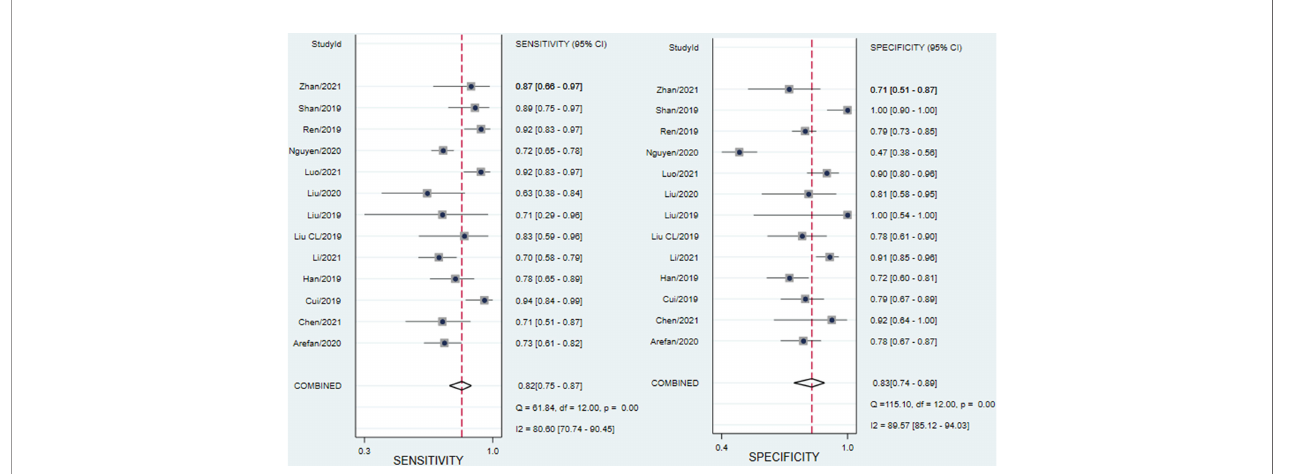
FIGURE 4 | Forest plots of the sensitivity and speci fi city of ML-based radiomics of DCE-MRI in predicting ALNM in breast cancer. I 2 >50% indicated substantial heterogeneity in the diagnostic parameters across